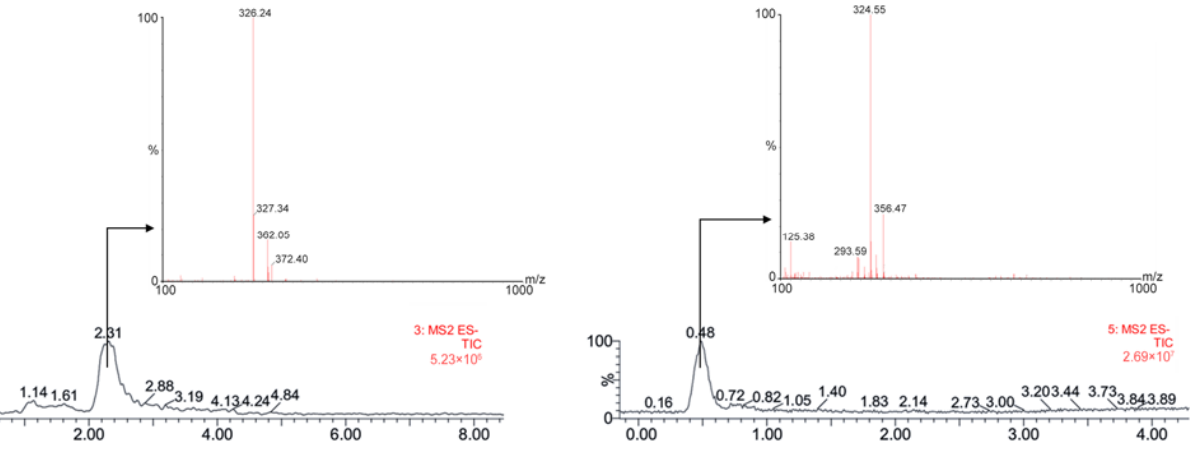
Figure 4. Full scans and mass spectra in the negative ion mode for synthesized NO 2 -OA ( right ) and NO 2 -LA ( left ) after purification.